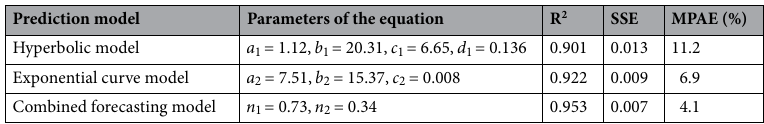
Table 7. Cumulative differential settlement prediction model of monitoring point 6.